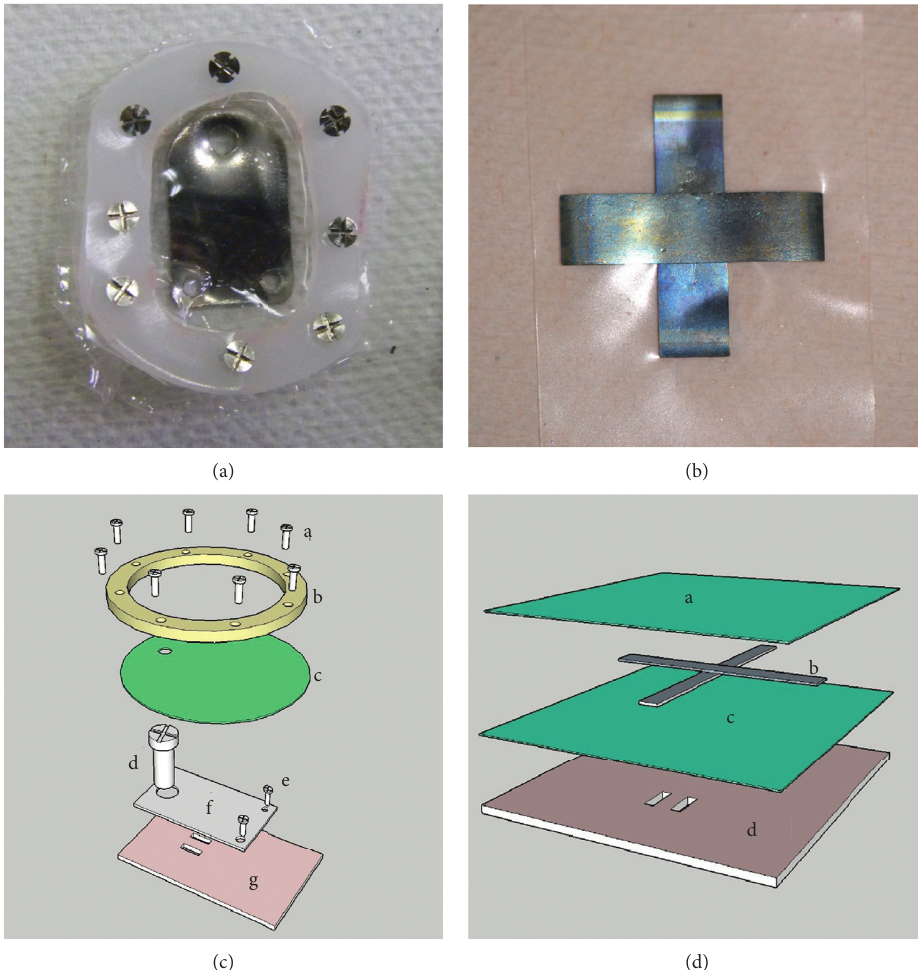
Figure 1: Photograph of (a) the expansible guided bone regeneration (EGBR) device and (b) the smart guided bone regeneration (SGBR) device. (c) Illustration showing the six components of the EGBR device: (g) original bone, (f) rectangular shape titanium elevating plate (16mm × 10mm × 0.5 mm), (e) titanium fixation miniscrews (3mm in length and 1 mm in diameter), (d) titanium elevating screw (5mm in length and 2mm in diameter), (b) plastic ring (24 mm × 18mm × 0.5mm external dimensions) with eight equidistant holes for (a) fixation screws. The (c) silicone membrane (0.05 mm thick) contains one hole for the activation screw (1.8mm wide). (d) Illustration showing the three components of the SGBR device: (a, c) two silicone sheets (22 mm width, 22mm length, and 0.25mm thickness), and (b) two Ni-Ti strips (14mm length, 2.5mm width, and 0.1mm thickness) placed perpendicular to each other (d) original bone tissue between groups. The statistical significance threshold was set at P < 0 . 05.